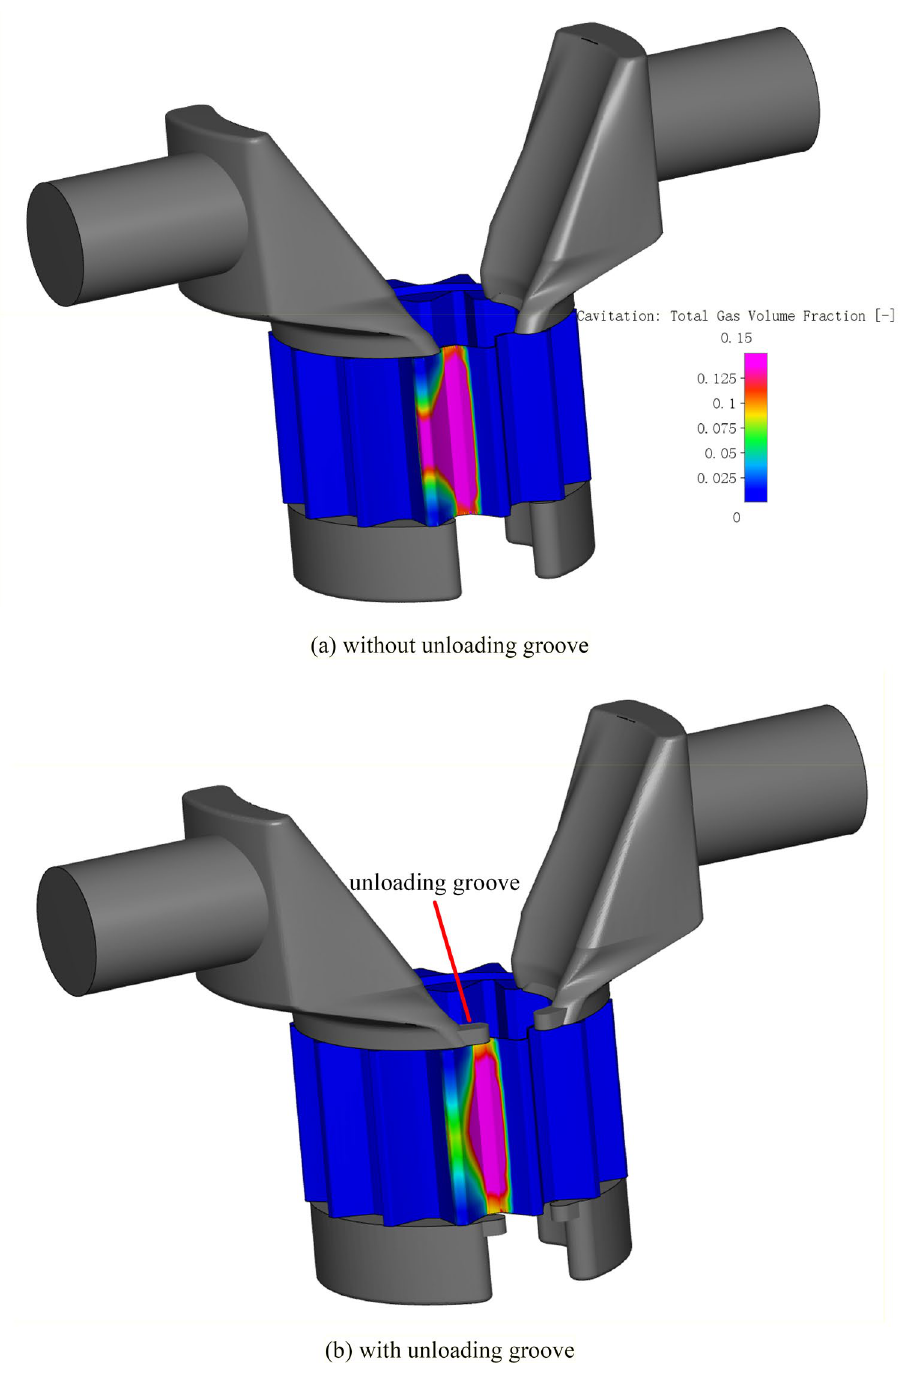
Figure 23. Cavitation field ( a ) without unloading groove; ( b ) with unloading